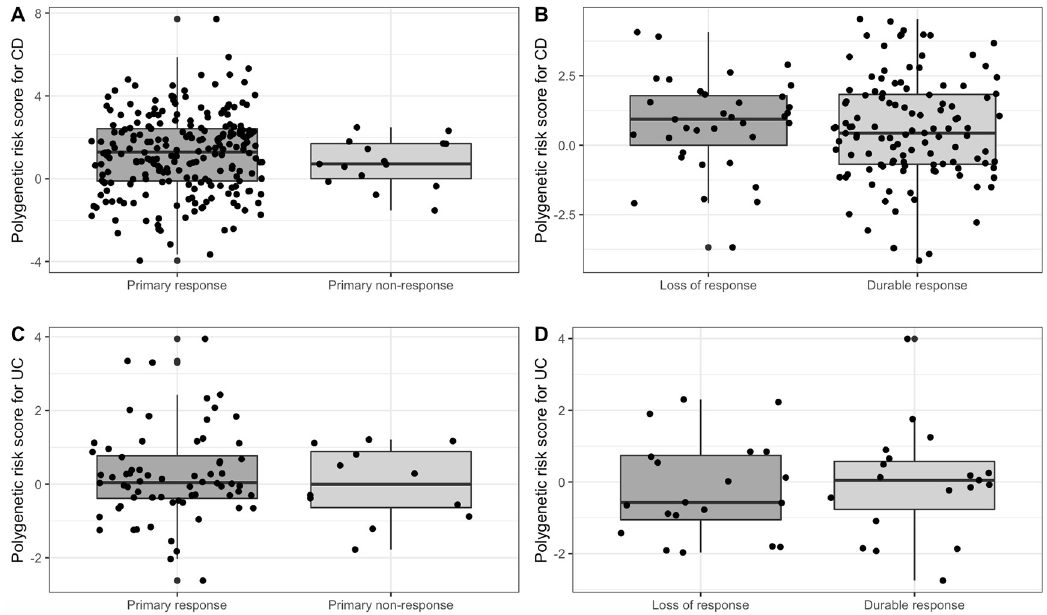
Fig 1. Boxplot representing the distribution of polygenetic risk scores for response in patients with inflammatory bowel disease. A Boxplot representing the distribution of polygenetic risk score for primary non-response in patients with Crohn’s disease with primary non-response and primary response; B Boxplot representing the distribution of polygenetic risk score for durable response in patients with Crohn’s disease with durable response and loss of response; C Boxplot representing the distribution of polygenetic risk score for primary non-response in patients with ulcerative colitis with primary non-response and primary response; D Boxplot representing the distribution of polygenetic risk score for durable response in patients with ulcerative colitis with durable response and loss of response.